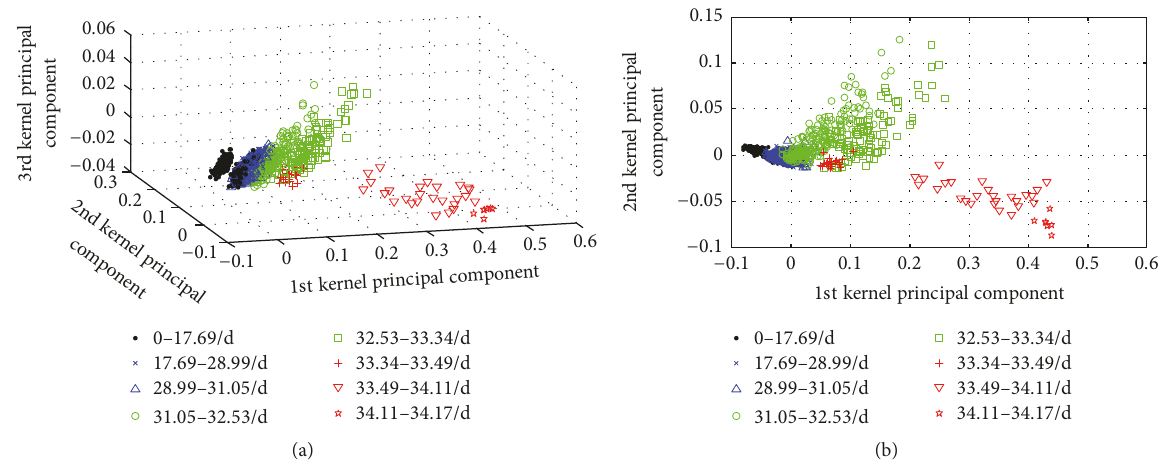
Figure 7: Kernel principal component projection: (a) the first three Kernel principal components; (b) 1st kernel principal component and 2nd Kernel principal component.